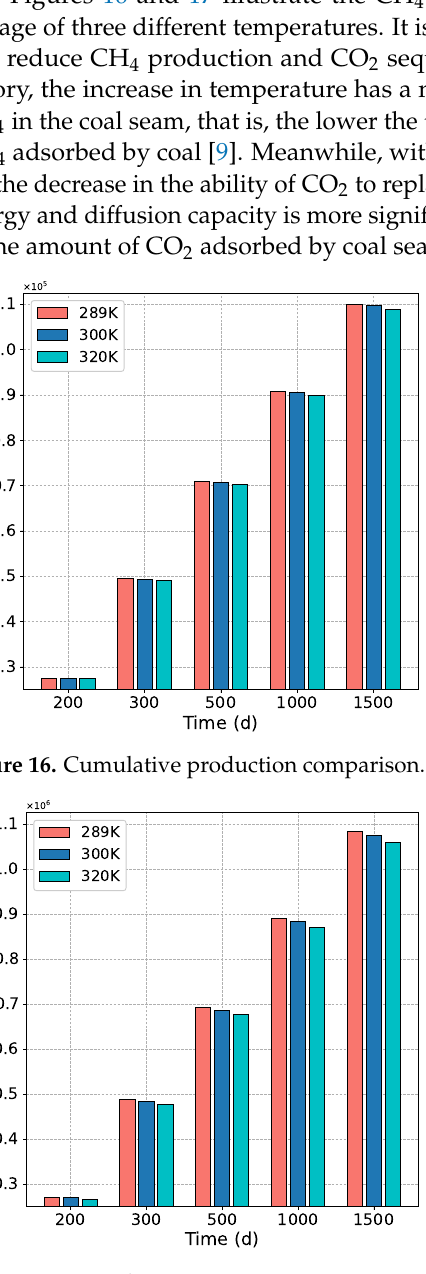
Figure 17. Cumulative CO 2 storage